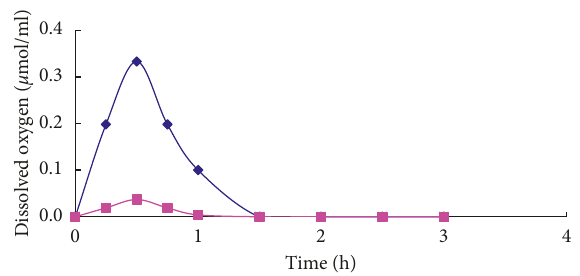
Figure 5: Effects of β -CD on dissolved oxygen in tea infusion. Solid line with “ ” represents conventional infusion; solid line with “ represents infusion made with 0.05% β -CD when extraction. Dissolved oxygen levels were measured from aliquots of the same ◆ sample or from different samples over the course of